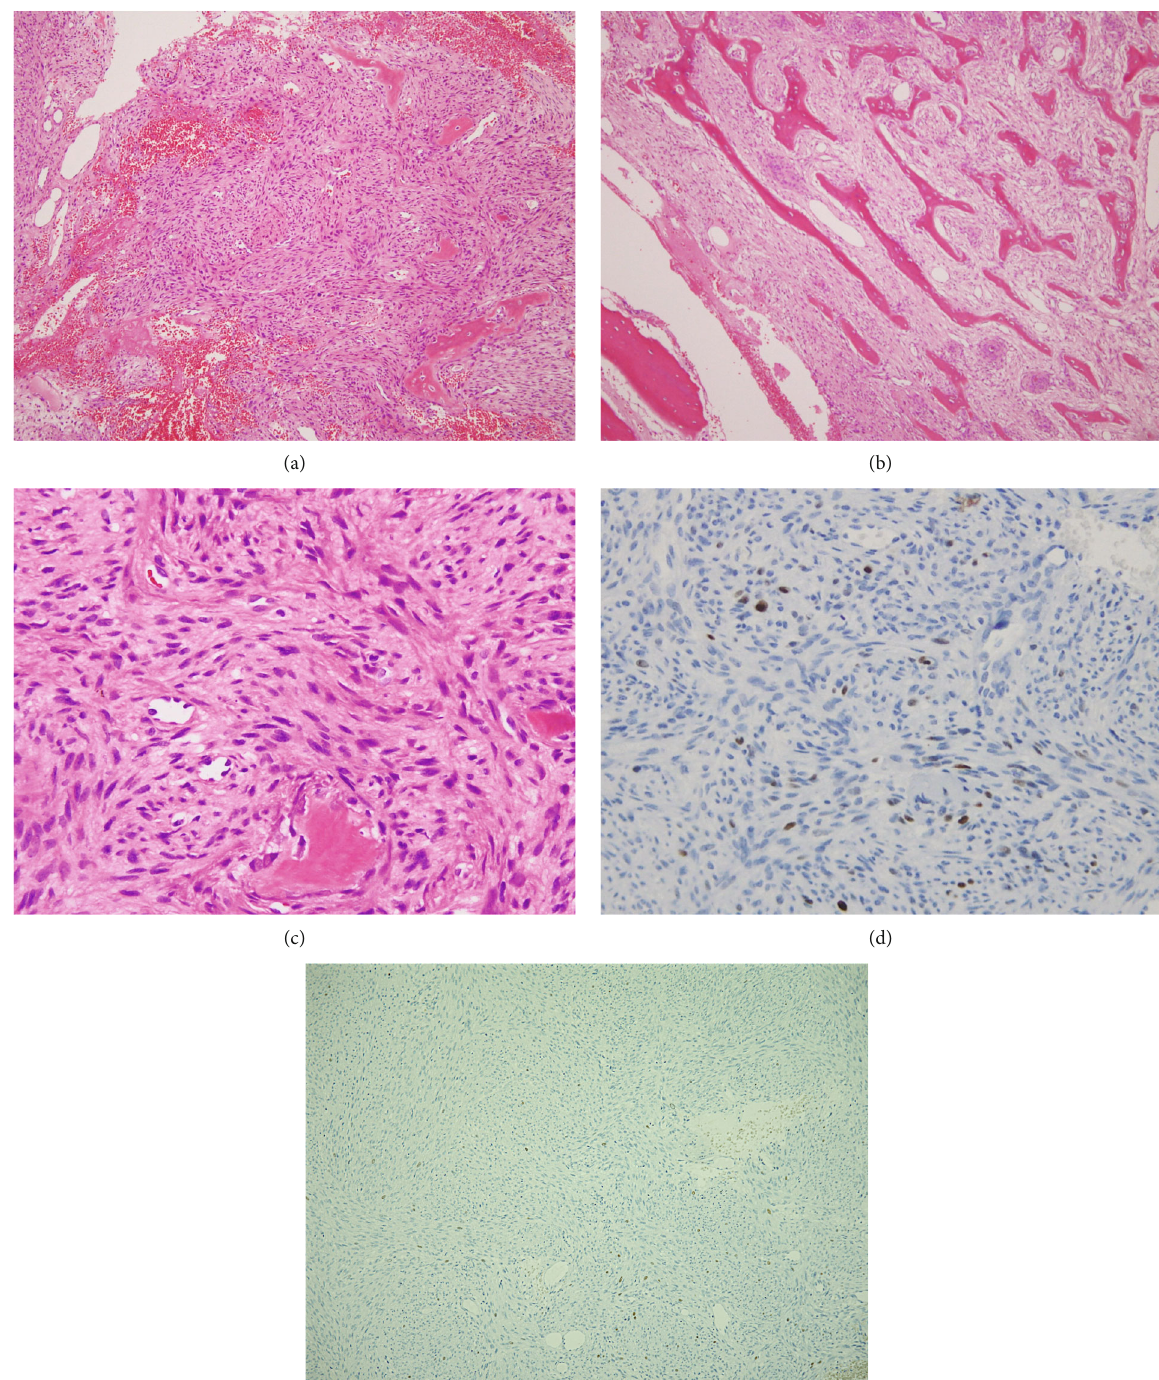
Figure 2: (a) Hematoxylin and eosin staining of the fi rst enucleation ( × 100). (b) Hematoxylin and eosin staining after the fi rst enucleation ( × 100). (c) Hematoxylin and eosin staining after the fi rst enucleation ( × 200). The bundle of spindle cells runs across, and a storiform pattern is observed. Randomly formed woven bone is also observed. There is no atypia, and few mitoses are observed (2 – 3/50 high-power fi elds). (d) Immunohistochemical staining. The tumor is positive for MDM2(+). (e) Immunohistochemical staining: Ki-67 index of 2 –